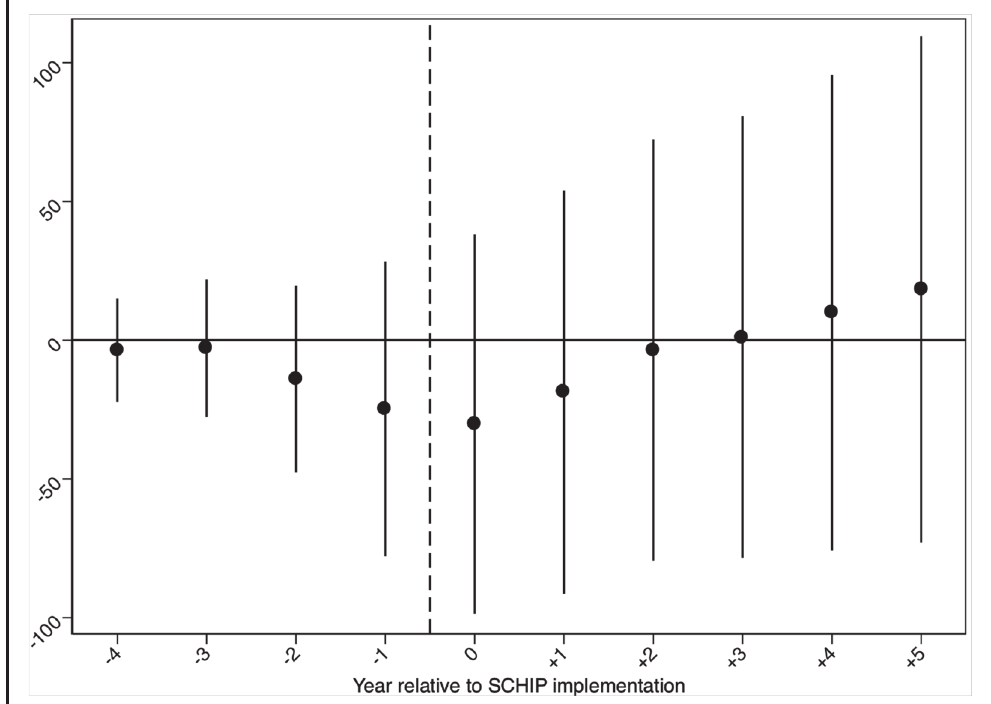
Event Study for the Impact of SCHIP on Immigrant Inflows to Generous